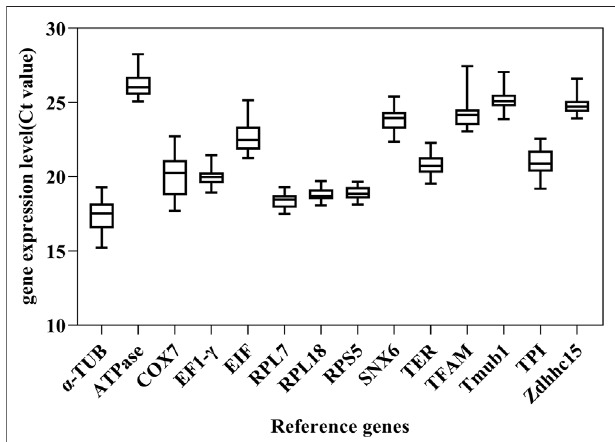
FIGURE 1 | Cycle threshold (Ct) values of 14 candidate reference genes across total samples in M. saltuarius . Boxes indicate the 25th and 75th percentiles, and lines in the boxes represent the median